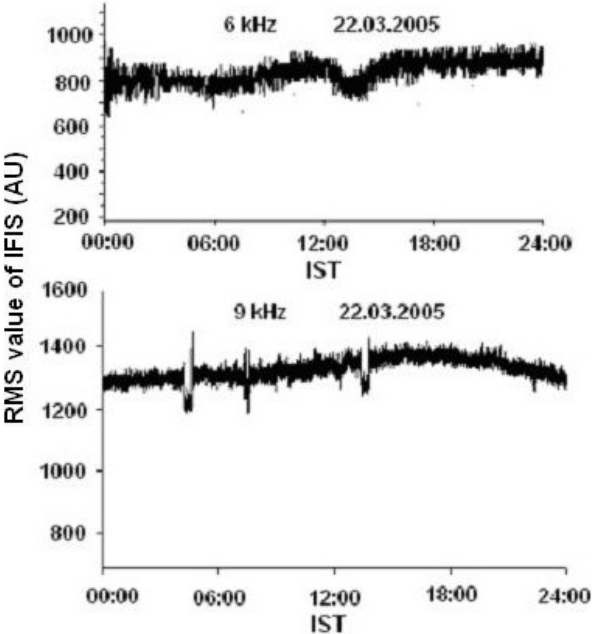
Fig. 3. A normal day record of sferics at 6kHz and 9kHz in a meteorologically clear day.